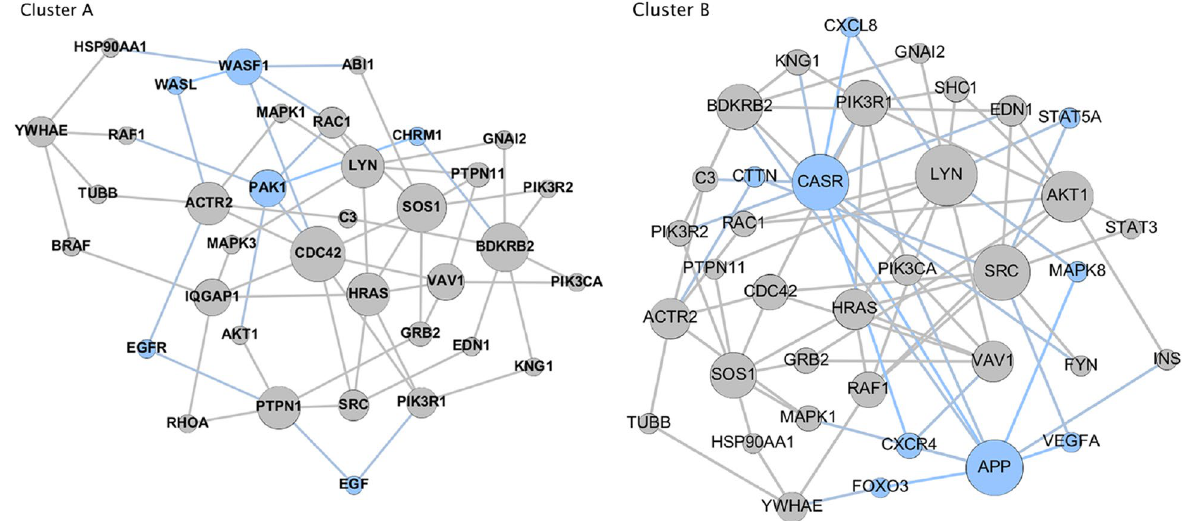
Figure 2. Layered network graphs for the case dominated clusters A & B from Fig. 1. The unique genes associated with each cluster are highlighted in light blue.